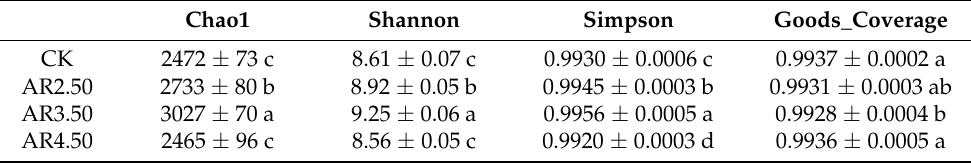
Table 2. Soil bacterial community α -diversity indexes under different treatments. Chao1